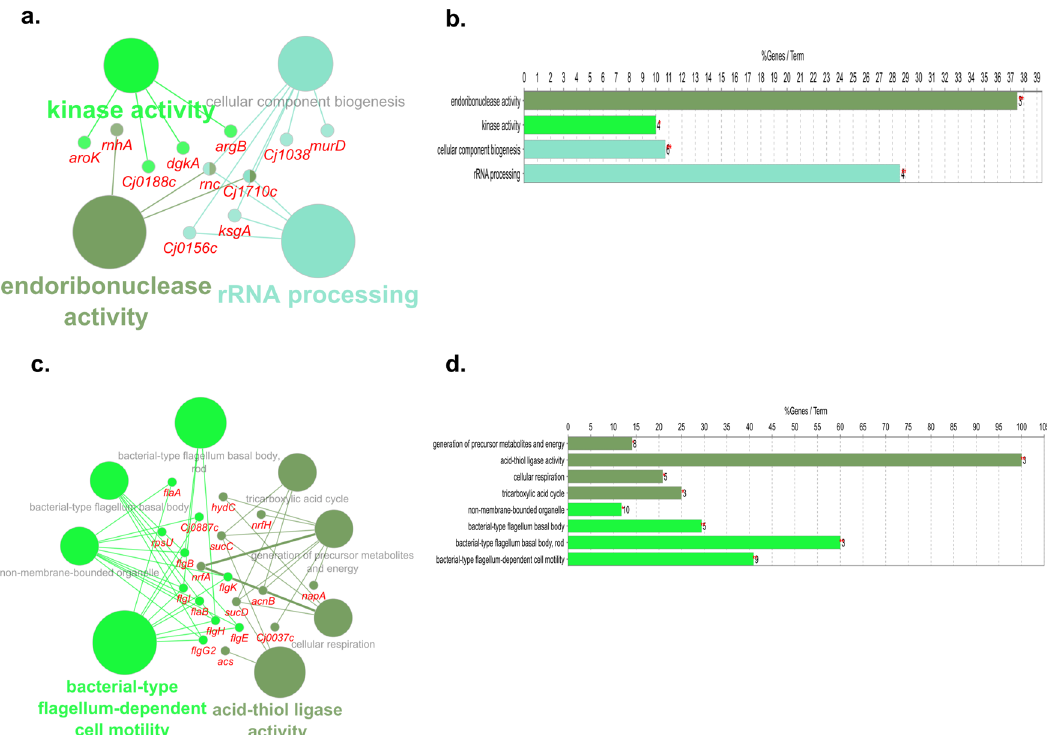
Fig. 5 Biological pathway analysis of DEGs in exposure to ASC vs. chlorine at 5 °C. Pathways enriched by mapping the upregulated ( a , b ) and downregulated ( c , d ) DEGs at 5 °C. DEGs signi fi cantly (FDR < 0.05; log 2 fold change >1 or < − 1) regulated in C. jejuni were mapped in ClueGO and CluePedia plugins in Cytoscape and only signi fi cantly ( P < 0.05) enriched biological pathways were visualized. In the graph, the length of individual bars indicates the percent of DEGs associated with respective terms out of the total associated